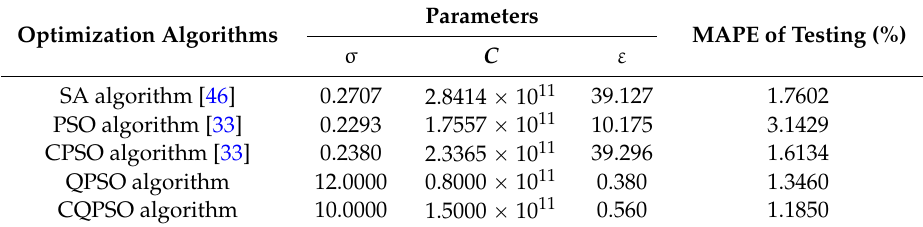
Table 4. Parameter determination of SVRCQPSO and SVRQPSO models (example two).